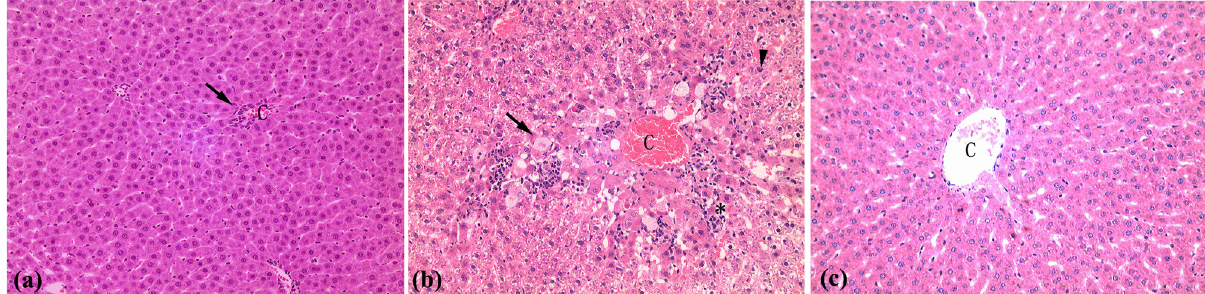
Figure 3: Pathological changes in the liver after administration of for 48 h. ( a ) The lobules were intact with in fl ammatory cells in fi ltrating ( arrow ) in central veins ( DMF group, HE 100 ×) . ( b ) Balloon - like degeneration and steatosis ( arrow ) , spot - like necrosis ( * ) , and partial apoptosis ( triangle ) of hepatocytes around the central vein, accompanied by some in fl ammatory cell in fi ltration ( CCl 4 group, HE 100 ×) . (